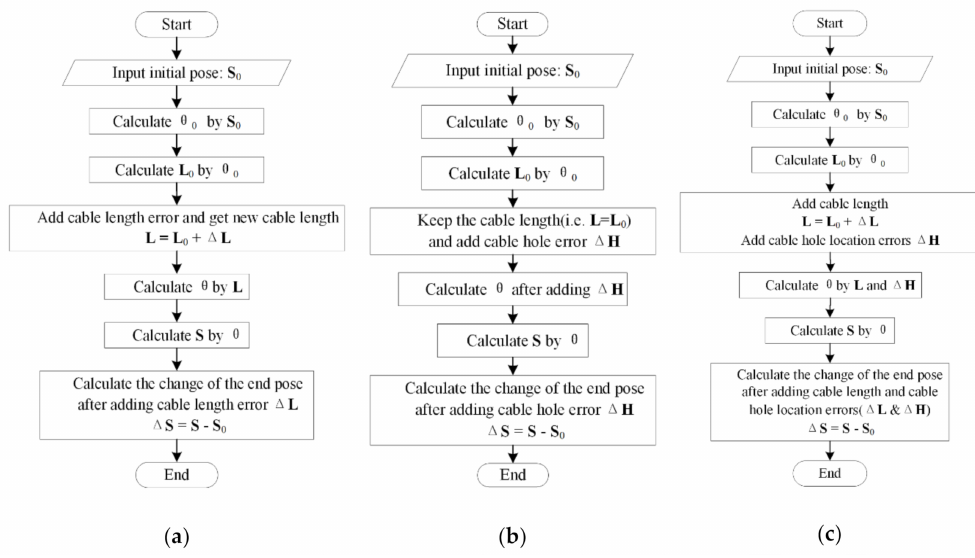
Figure 3. Flow charts to study the errors. ( a ) The method to study the cable length error; ( b ) the method to study the cable hole location error; ( c ) the method to study the combined cable length and cable hole location